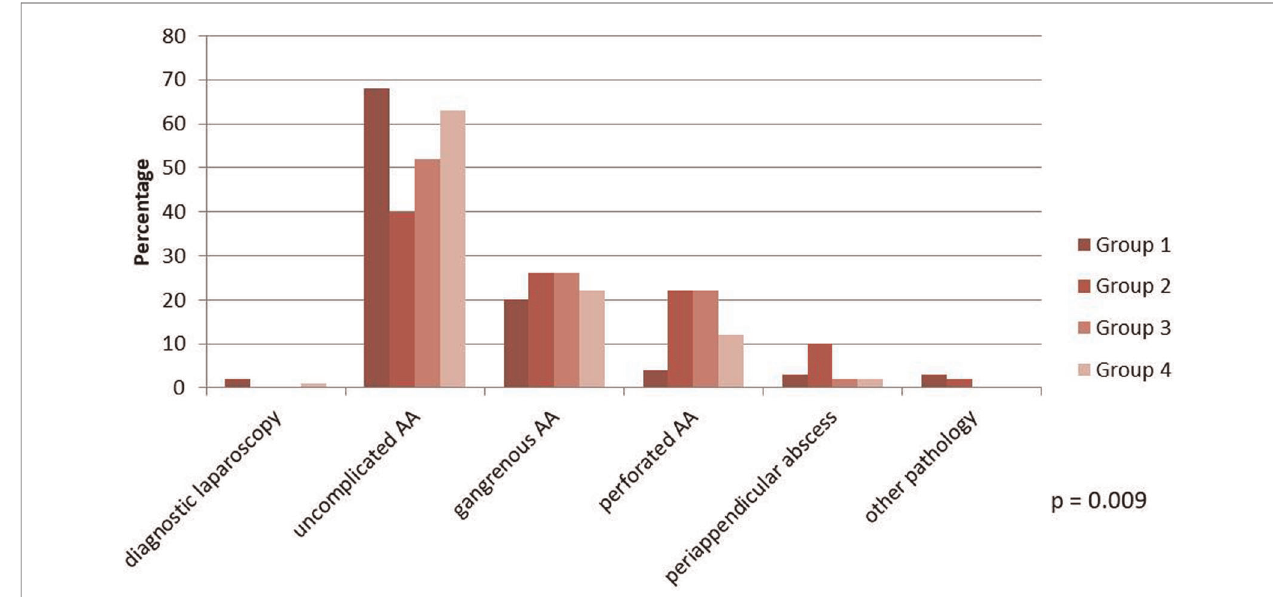
FIGURE 2 | Results of patients operated for acute